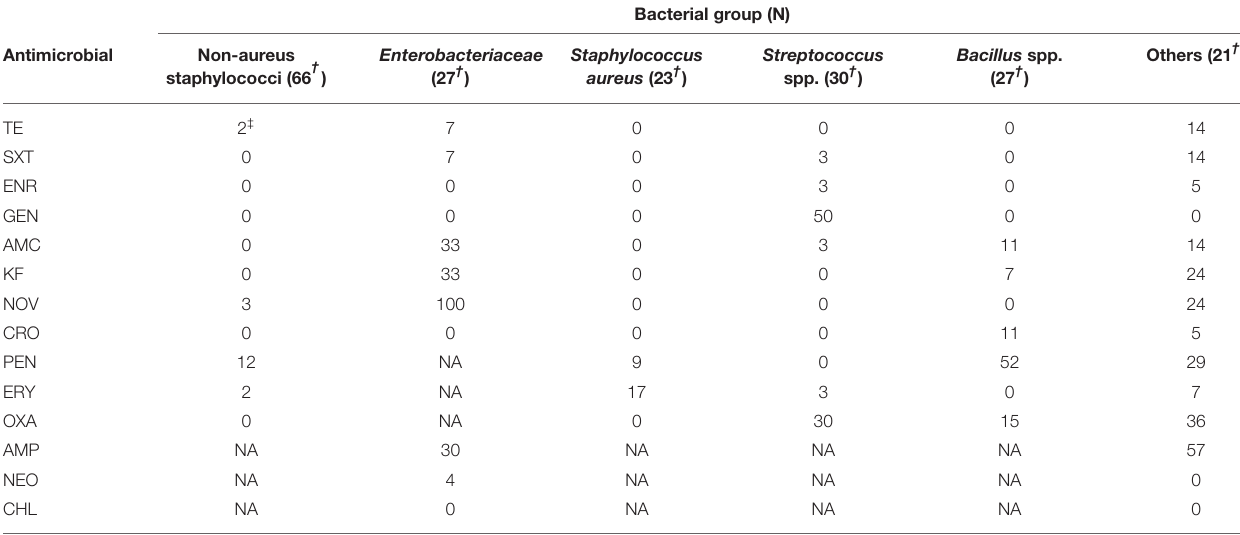
TABLE 4 | Counts and percentages antimicrobial resistance in bacterial groups.